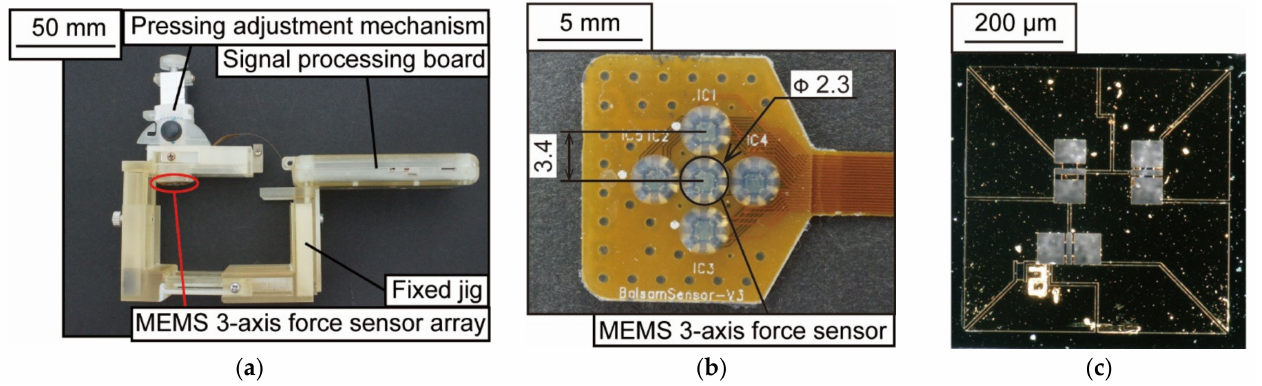
Figure 5. A photograph of the blood pressure pulse wave measurement device: ( a ) Wearable device; ( b ) MEMS 3-axis force sensor array; ( c ) Force sensor